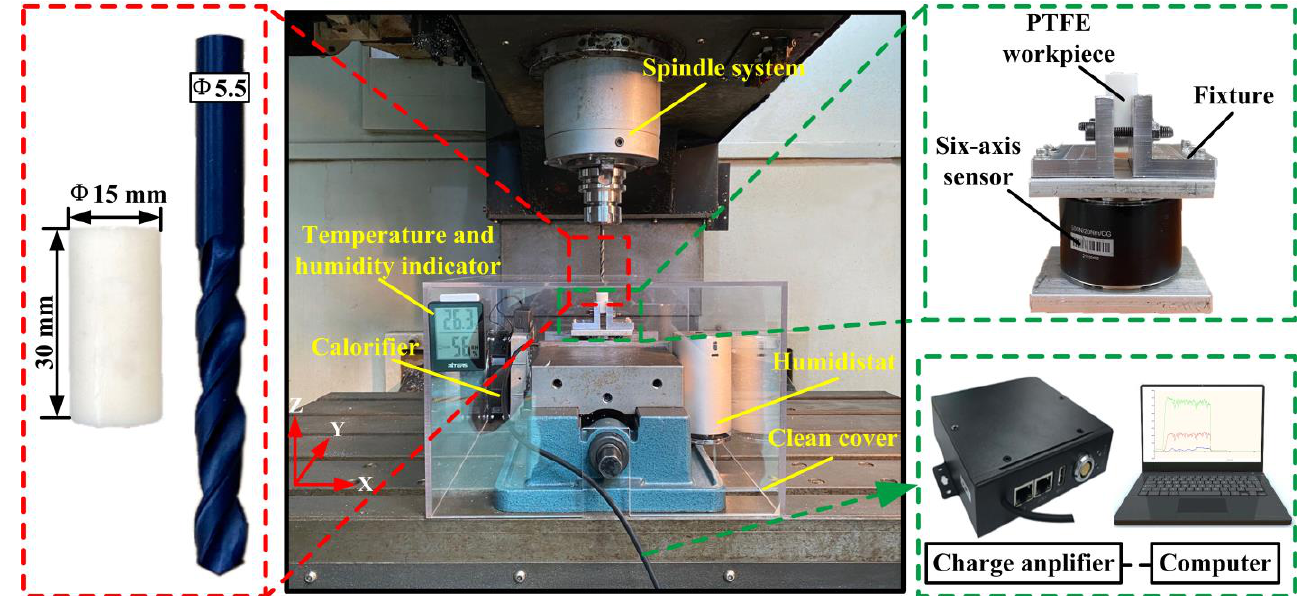
Figure 2. Experimental system setup.